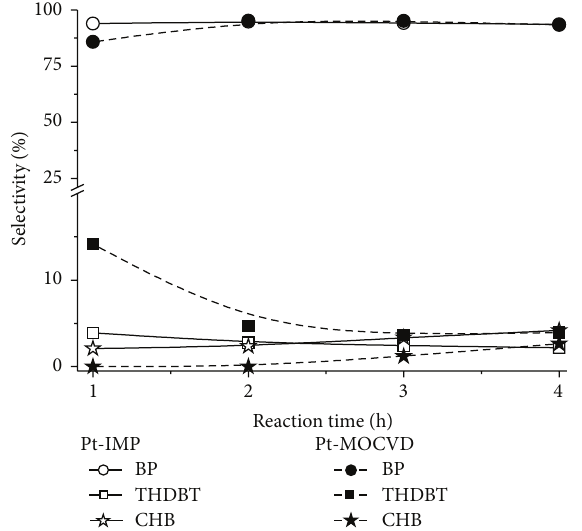
Figure 7: Profiles of HDS selectivity over monometallic Pt catalysts evaluated in the HDS of